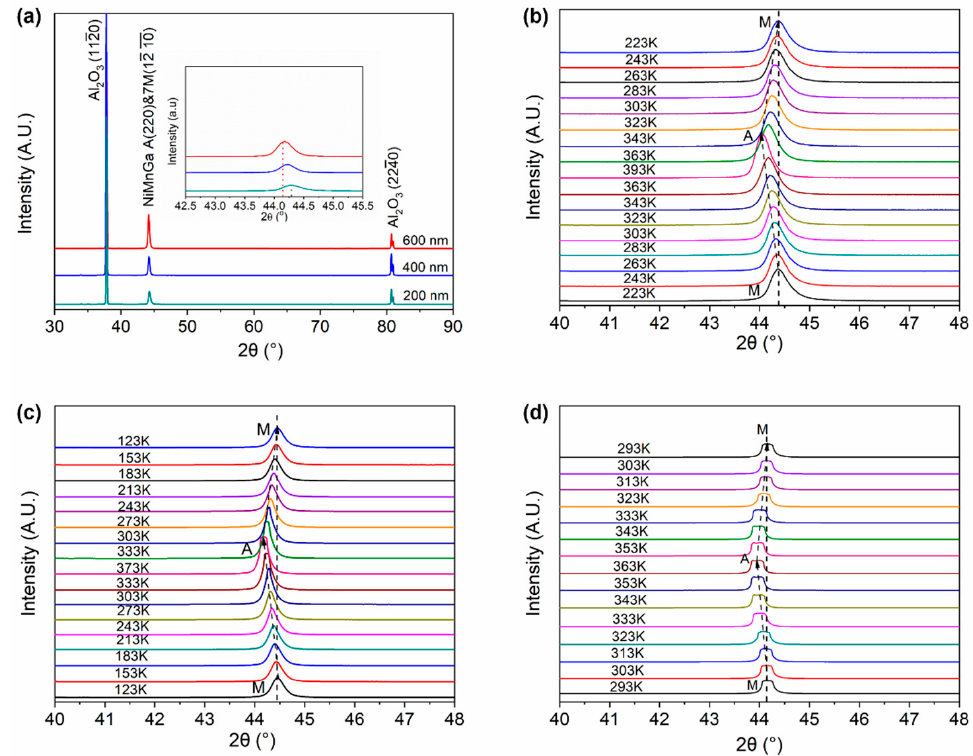
Figure 1. ( a ) X-ray diffraction pattern of Ni 51.0 Mn 27.5 Ga 21.5 thin films with different thicknesses and ( b – d ) the corresponding temperature-dependent XRD patterns. ( b ) 200 nm, ( c ) 400 nm, and ( d ) 600 nm. In ( b – d ), A and M represent the Austenite and Martensite, respectively.